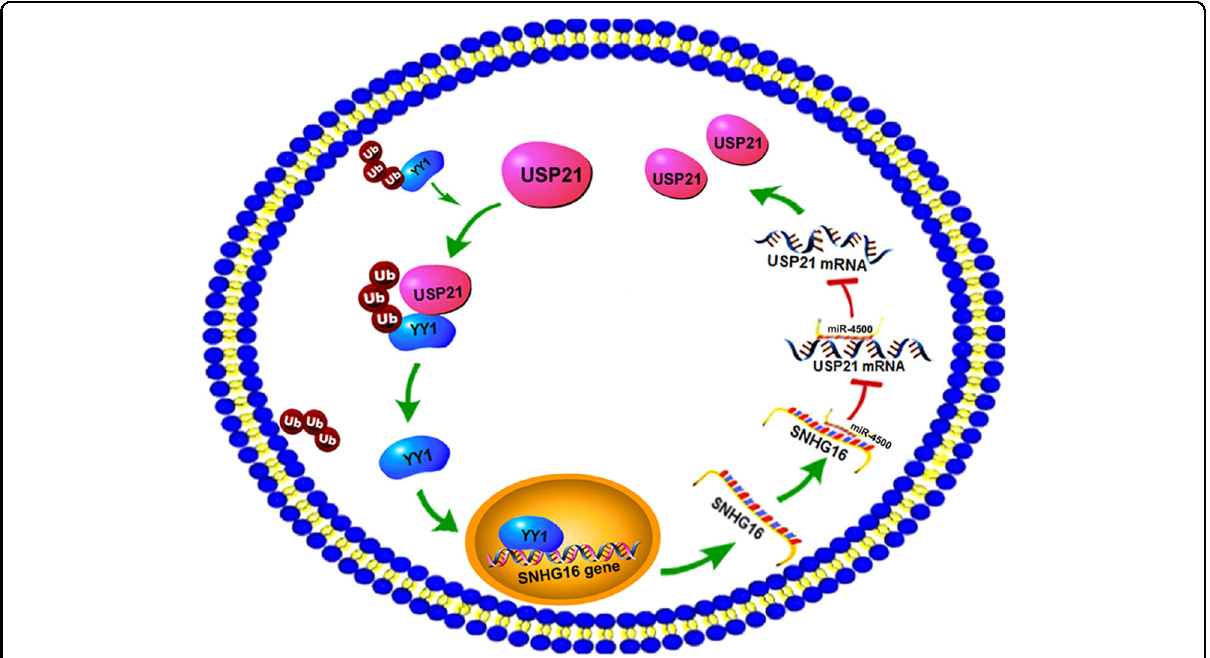
Fig. 8 Schematic diagram of the USP21/YY1/SNHG16/miR-4500 axis. USP21 deubiquitinates and stabilizes YY1, and YY1 transcriptionally activates lncRNA SNHG16, which further upregulates USP21 expression by binding to and suppressing